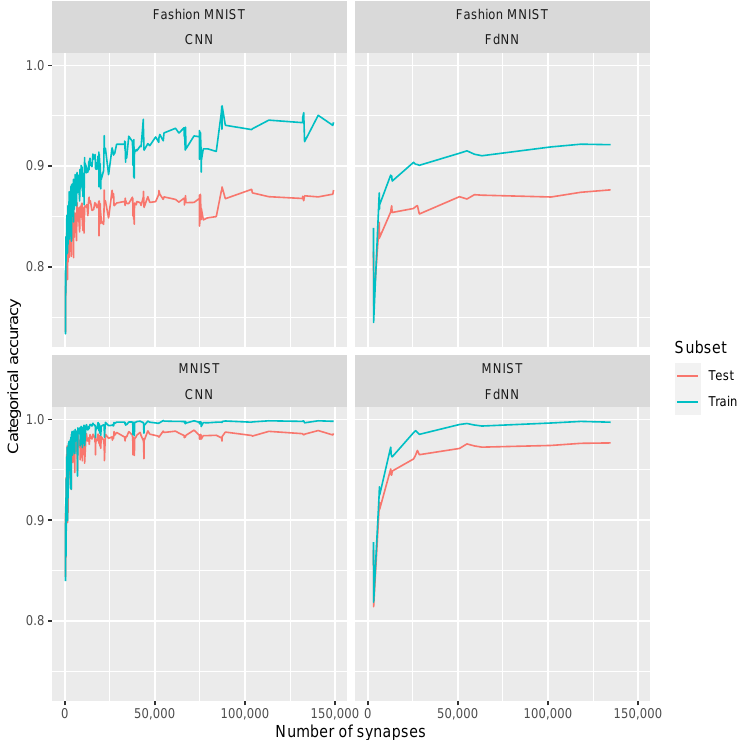
Figure 5. Categorical accuracy obtained for the MNIST and Fashion MNIST datasets in training and test for both FdNN and CNN using up to 150,000 synapses. We created different architectures in line with the previous two figures to modify the number of